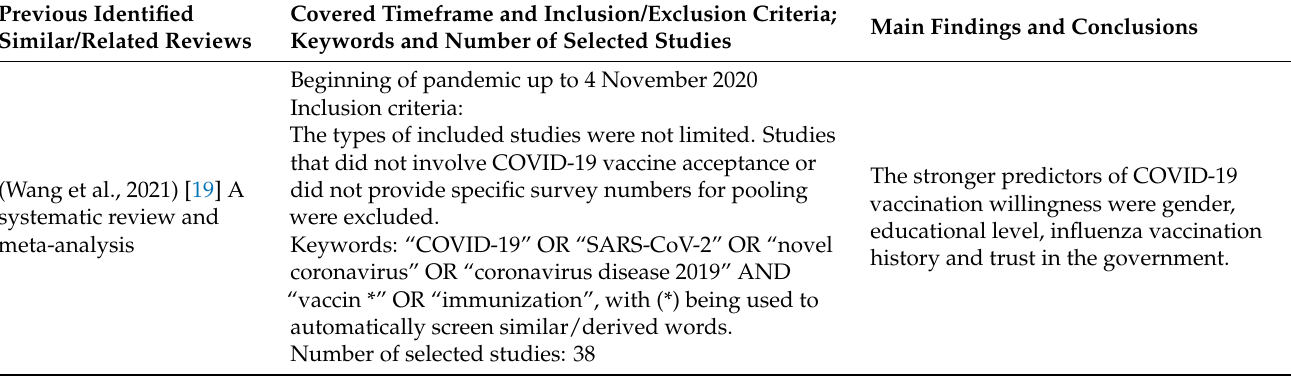
Table 2. Previous similar or related systematic reviews on predictors of vaccine